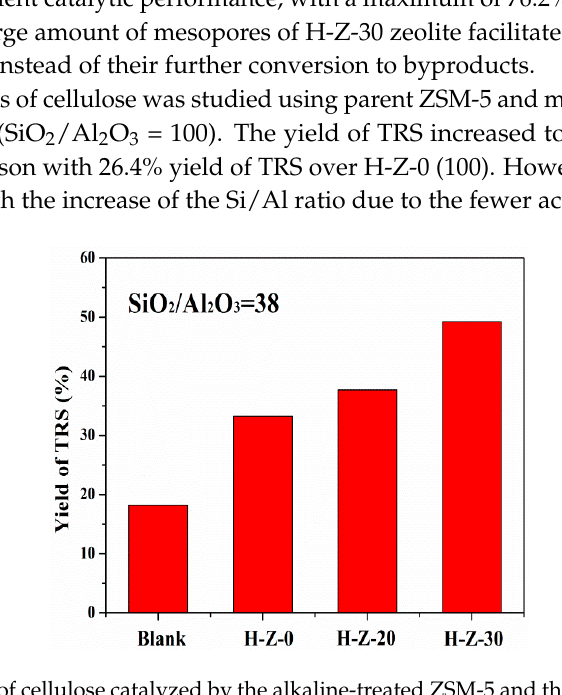
Figure 3. Hydrolysis of cellulose catalyzed by the alkaline-treated ZSM-5 and the parent ZSM-5 zeolites with SiO 2 /Al 2 O 3 ratio of 38. Reaction conditions: [BMIm]Cl (1.0 g), cellulose (50.0 mg), catalyst (50.0 mg), water (0.2 mL), at 403 K and 2 h.